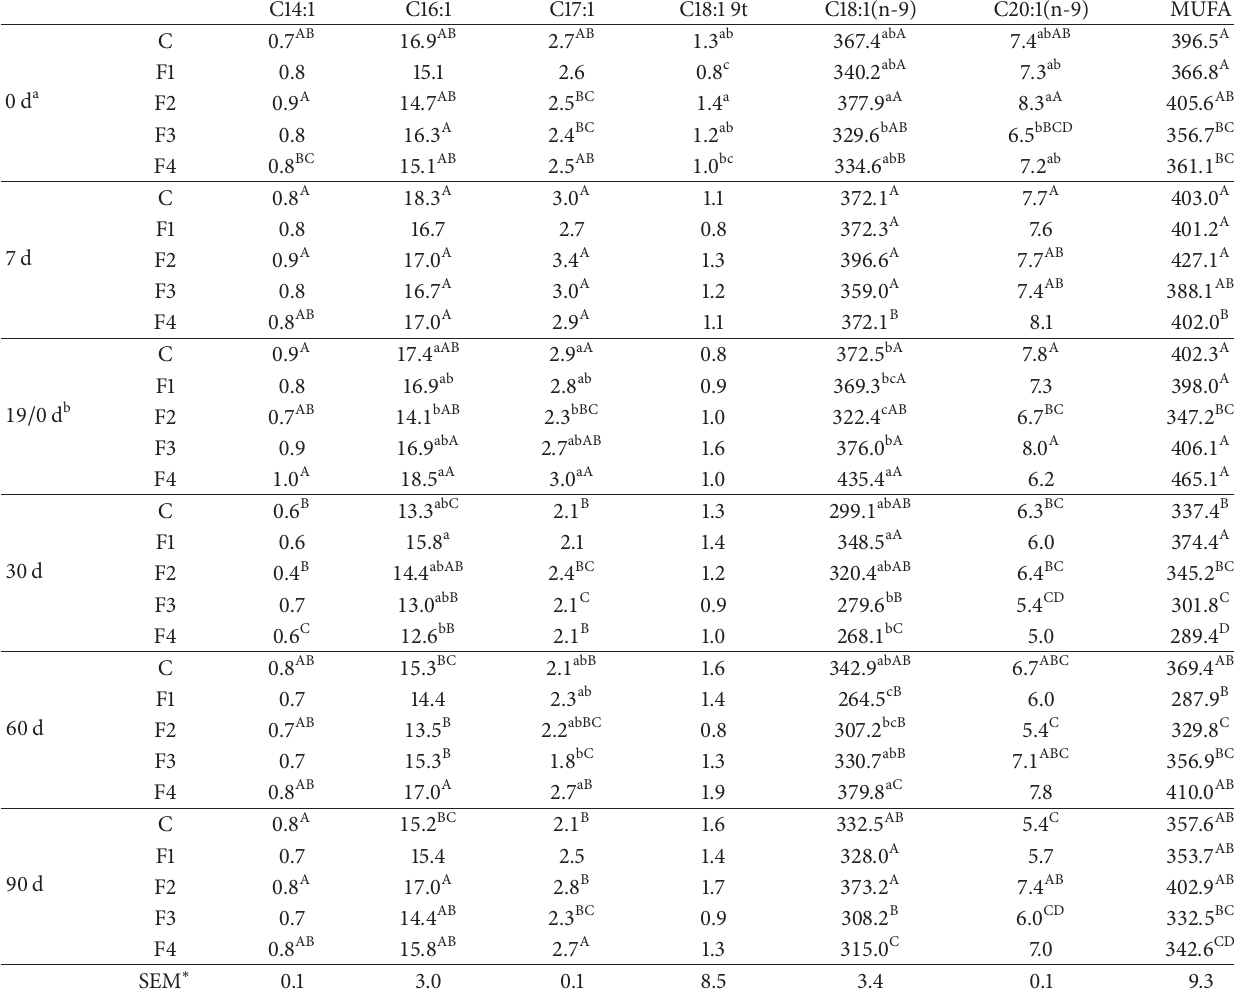
Table 3: Content of monounsaturated fatty acids (MUFA) in the lipid fraction (mg/g fat) during curing process and storage of salamis with NaCl reduced or replaced by KCl and/or CaCl 2